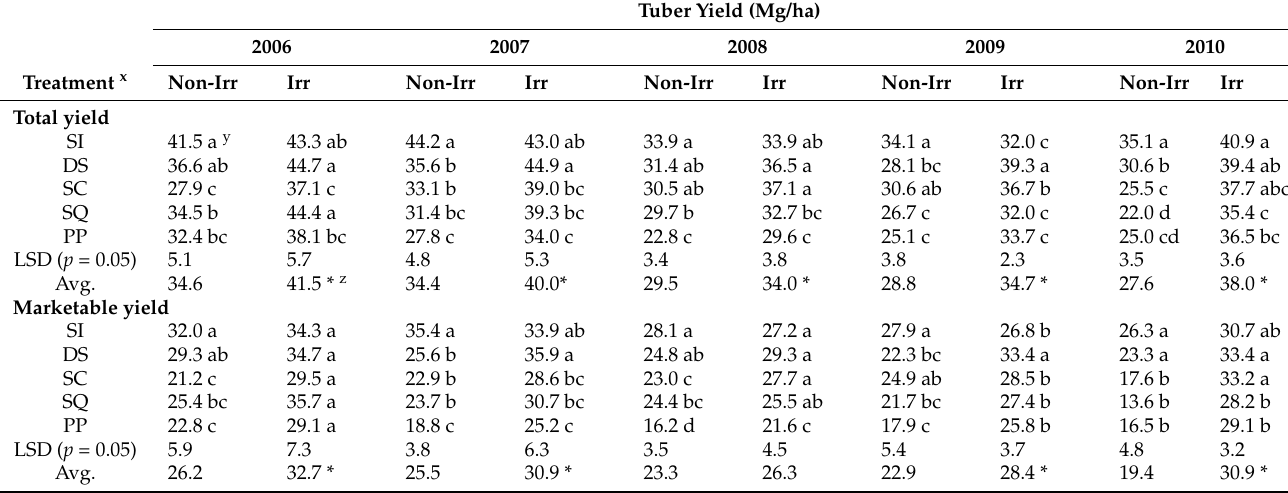
x SI = soil improving, SC = soil conserving, DS = disease suppressive, SQ = status quo, PP = continuous potato systems. y Values within columns for each yield type followed by the same letter are not significantly different from each other based on ANOVA and Fisher’s protected LSD test ( p < 0.05). z Mean values for irrigated treatments (Irr) followed by an asterisk are significantly greater than their corresponding non-irrigated (Non-irr) mean value within each year based on ANOVA and Fisher’s protected LSD